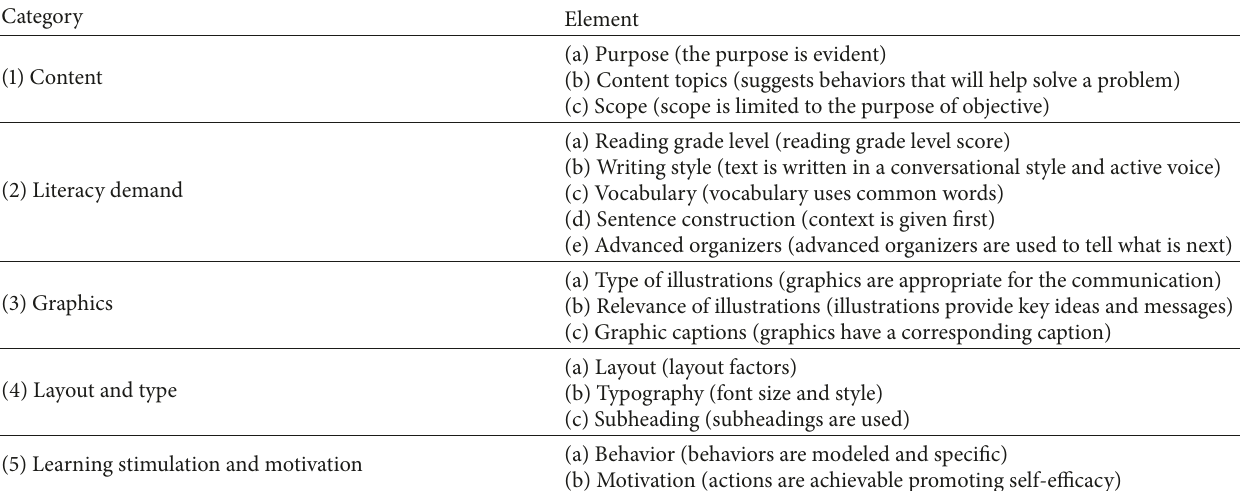
Table 2: Modified Suitability